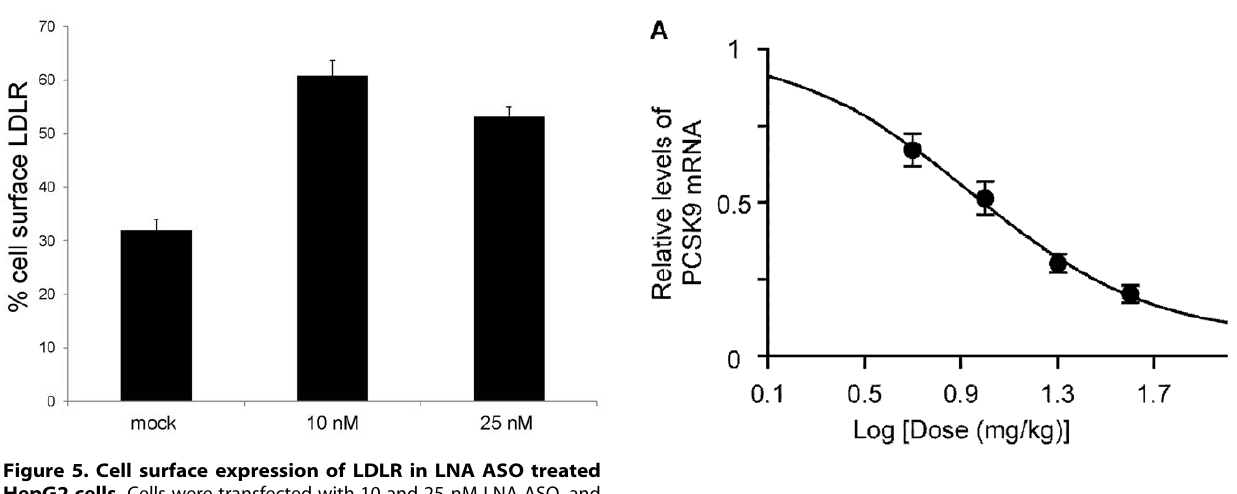
Figure 5. Cell surface expression of LDLR in LNA ASO treated HepG2 cells. Cells were transfected with 10 and 25 nM LNA ASO, and after 72 h FACS analysis was done to evaluate surface expression of LDLR using anti human LDLR as primary antibody and a suitable secondary antibody labeled with alexa 647.